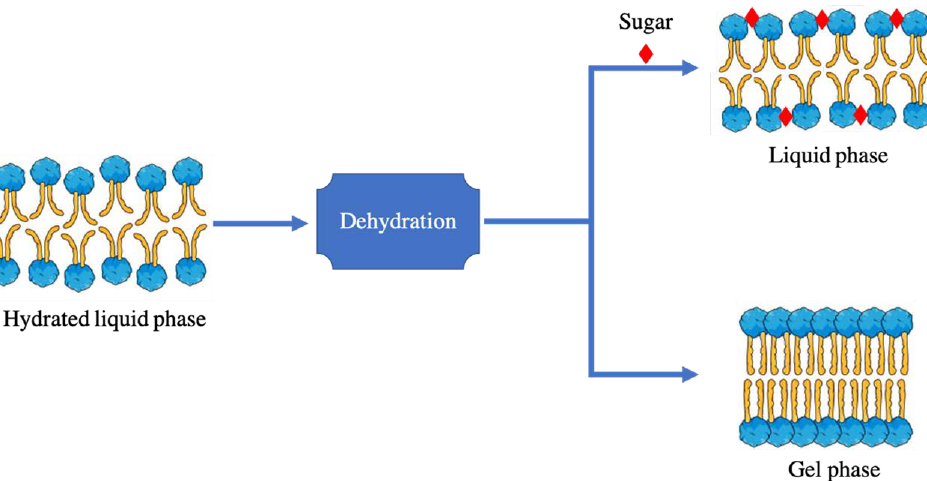
Figure 6. The effect of sugar to phospholipid bilayers before and after